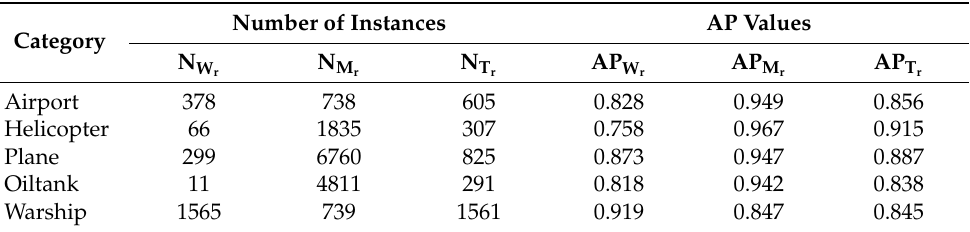
Table 4. The AP values of different object ratios on RSD-GOD testing